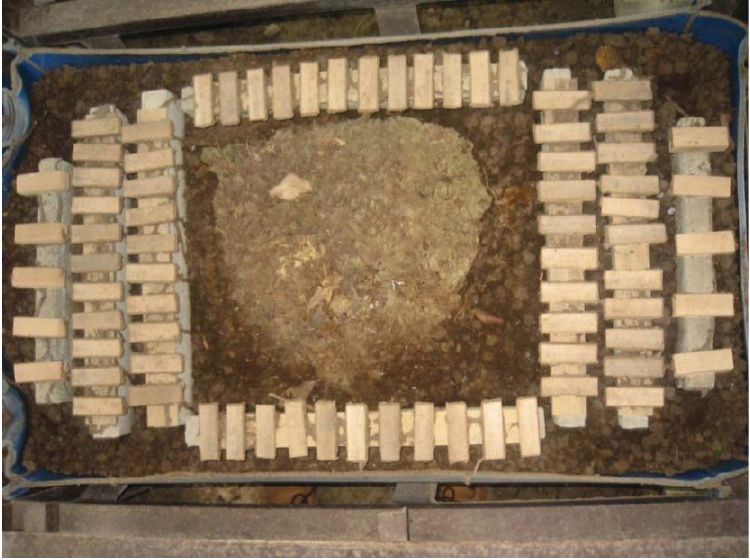
Figure 1. Experimental set-up for the termite resistance test.